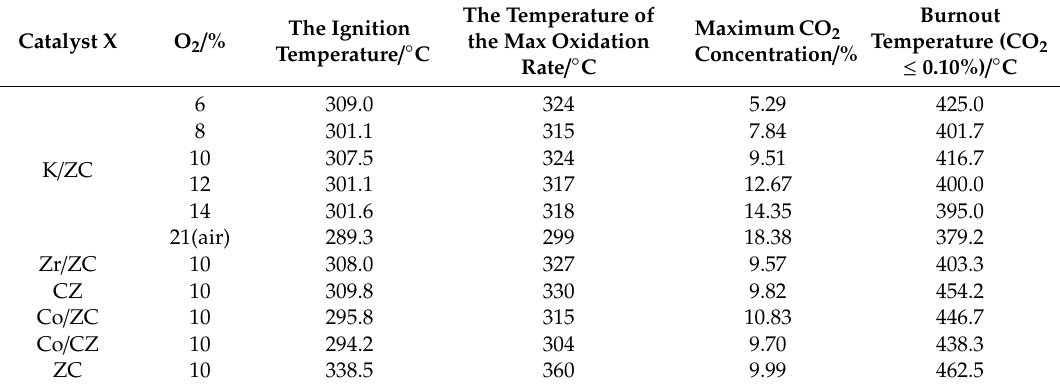
Table 3. The soot combustion parameters with catalysts (data from test platform). Catalyst X